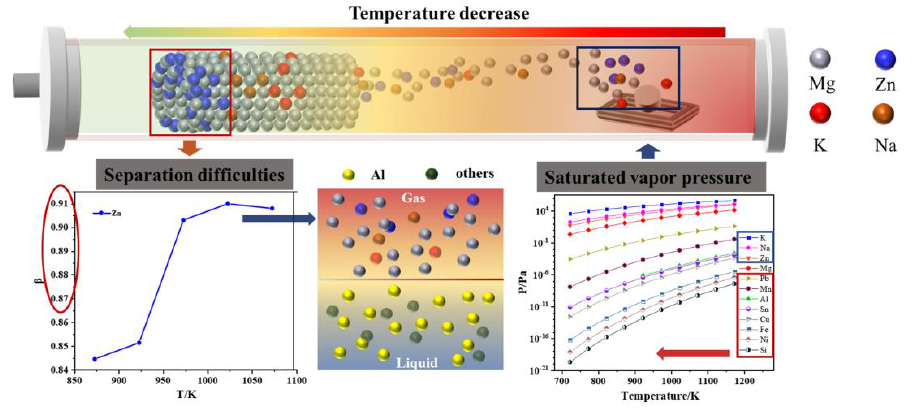
Figure 1. Schematic diagram of the purification of magnesium by vacuum gasification-directed condensation method.